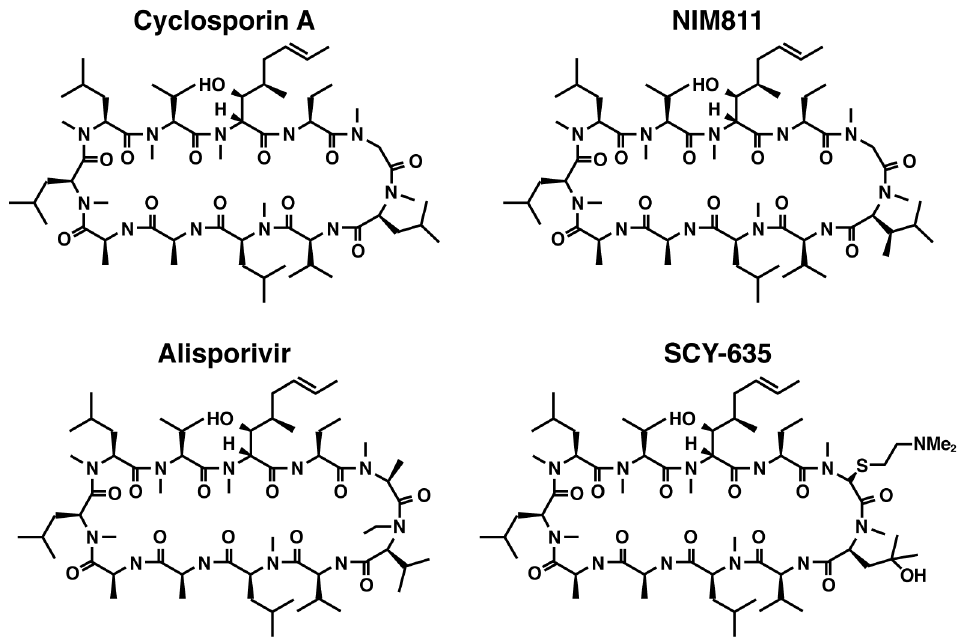
Figure 1. Structural formulas for Cyclosporin A together with three non-immunosuppressive derivatives including NIM811, Alisporivir, and